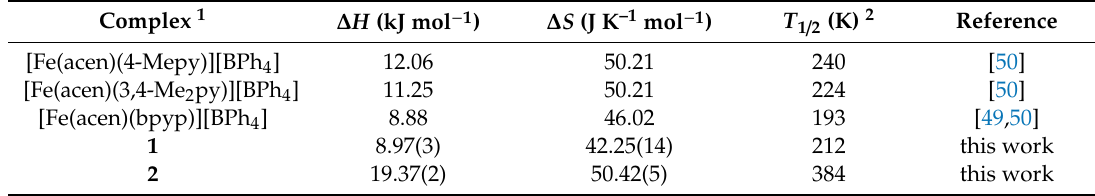
Table 4. Thermodynamic parameters and T 1 / 2 for 1 and related complexes.